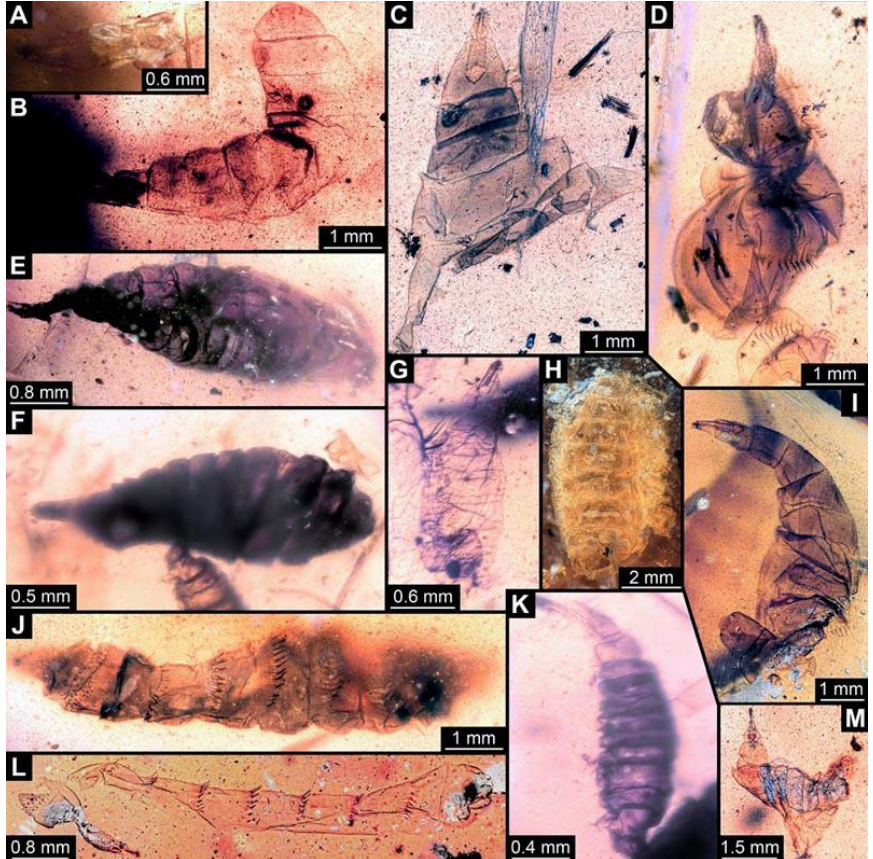
Figure 8. Several fossil larvae. ( A , B ). PED 0497. ( A ). Close-up of head capsule. ( B ). Overview. ( C ). PED 0599-1. ( D ). PED 0599-2. ( E ). PED 0550. ( F ). PED 0611-1. ( G ). PED 0611-3. ( H ). PED 0620. ( I ). PED 0601. ( J ). PED 0551. ( K ). PED 0611-2. ( L ). PED 0721. ( M ). PED 0691. (26) PED 0622: Specimen strongly bent between abdomen segments 2 and 3 (Figure 9A). Surface structure apparent. Head capsule well preserved. Ventral spine-like setae on abdomen segments well developed. The total body length could not be reliably measured. (15) PED 0599-1: Specimen torn off at abdomen segment 2. Head, thorax and abdomen Dimensions: body width 3.33 mm, head capsule length 1.37 mm, head capsule width 0.27 mm.